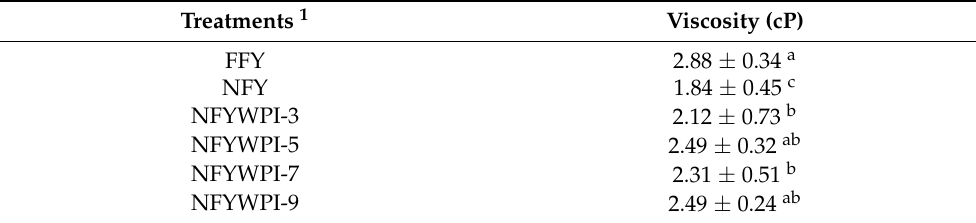
Table 1. The viscosity of yogurt mixes measured in different